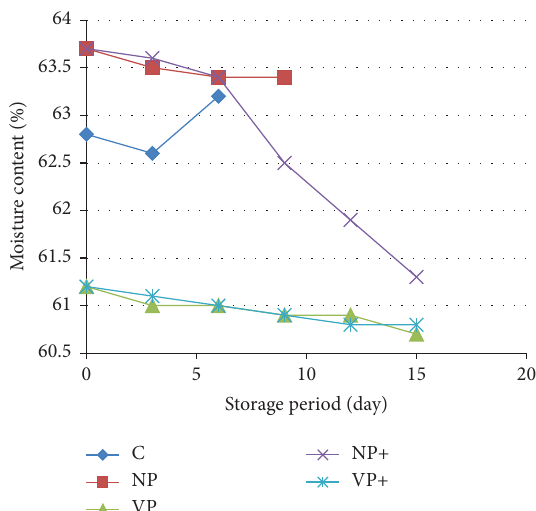
Figure 3: Moisture content (%) of injera with respective treatments at diferent storage intervals. For “C” and “NP” treatments, the experiment was terminated at 6 th and 9 th day of storage, re- spectively, since the samples were